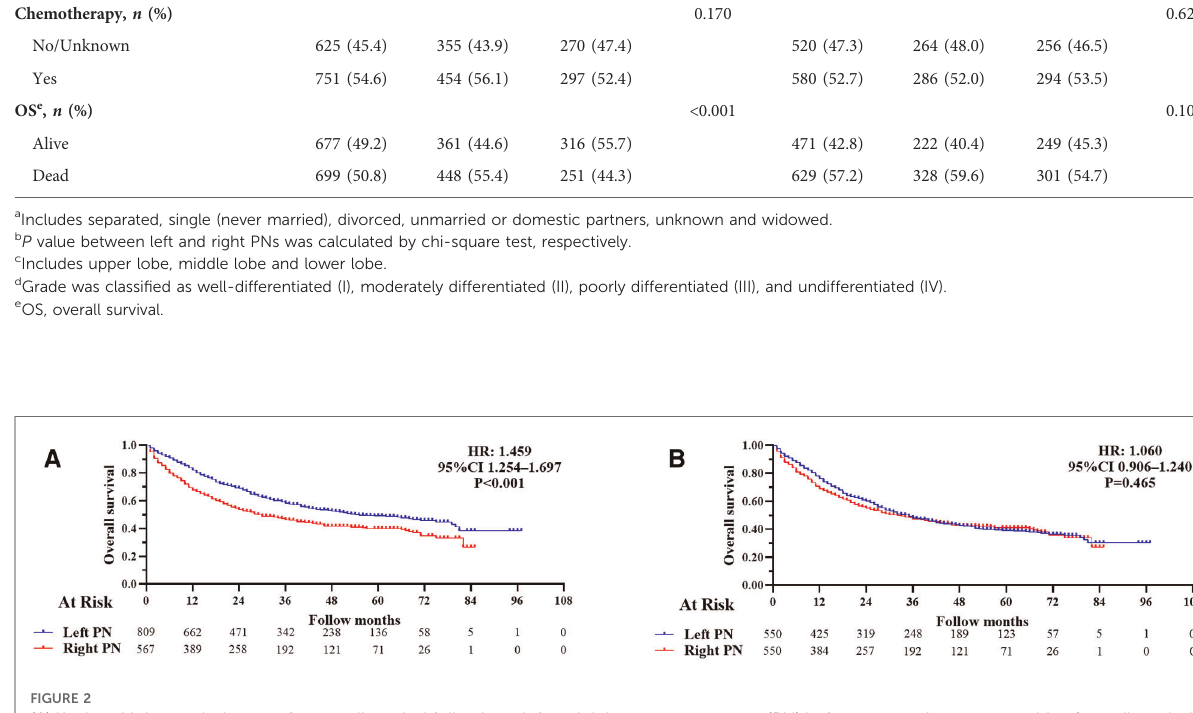
FIGURE 2 ( A ) Kaplan – Meier survival curves for overall survival following a left and right pneumonectomy (PN) before propensity score matching (overall survival, hazard ratio (HR): 1.459; 95% CI 1.254 – 1.697; P <0.001). ( B ) Kaplan – Meier survival curves for overall survival in left and right PN after propensity score matching (overall survival, HR: 1.060; 95% CI 0.906 – 1.240; P